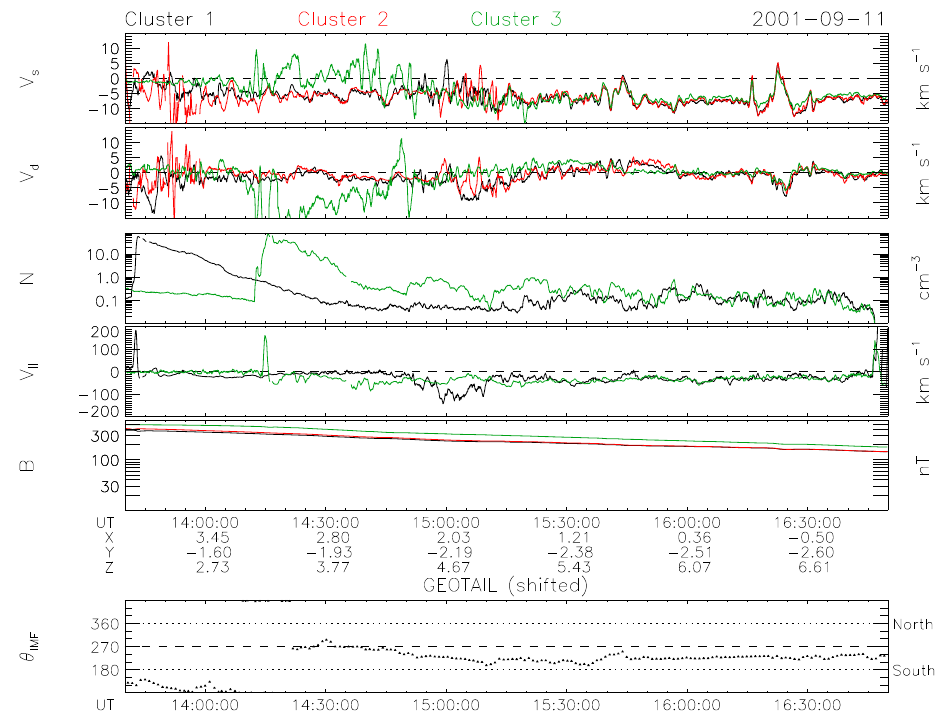
Fig. 4. Data for an outbound pass on 11 September 2001 in the same format as Fig. 3, except that EDI and FGM data are shown for C1, C2, and C3 (using the standard colors black, red and green, respectively), CIS-HIA data for C1 and C3 (not available on C2), and GEOTAIL data are used instead of ACE data for the IMF clock